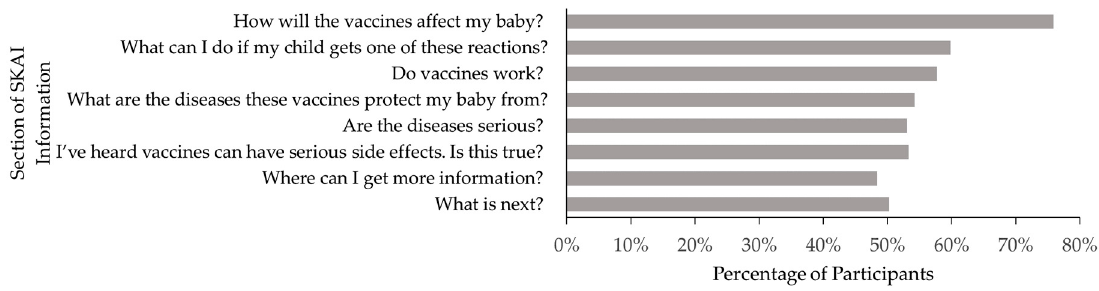
Figure 2. Percentage of Participants Who Viewed the Sharing Knowledge About Immunisation (SKAI) Information, by Section.